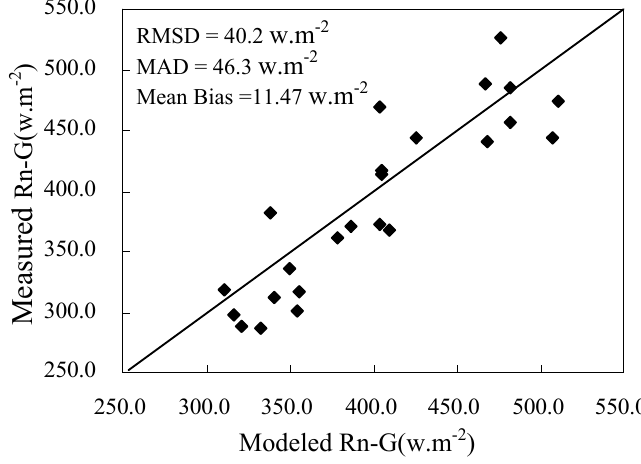
Figure 5. Modeled versus measured available energy, R relationship.